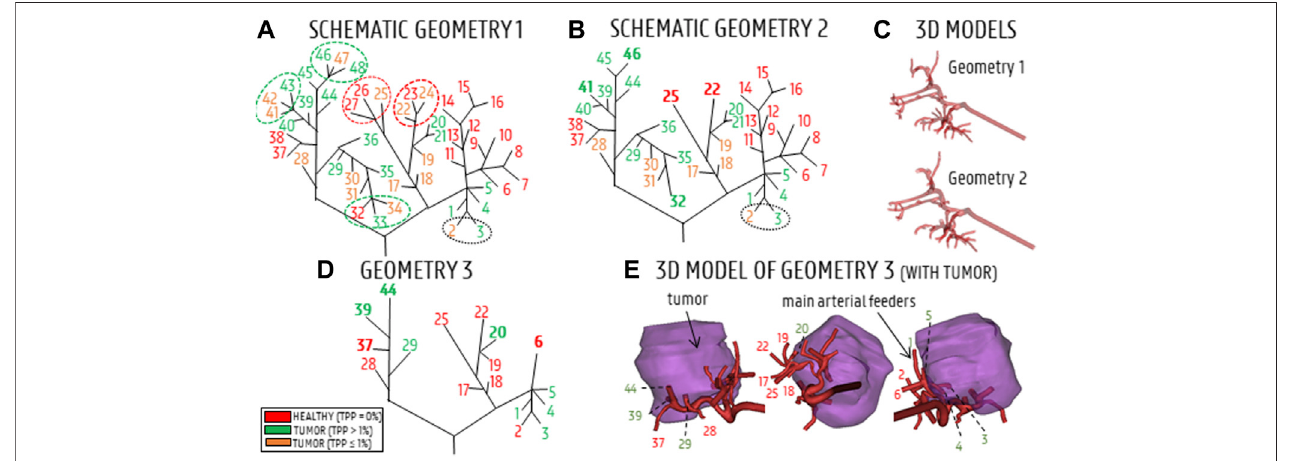
FIGURE2|(A) SchematicofGeometry 1.Redbranchesindicatehealthybranches (TPP=0%), orangebranchesindicatebranchesthatperfuseasmallfraction of thetumor(TPP ≤ 1%),greenbranchesindicatebranchesthatperfuseasigni fi cantportionoftumortissue(TPP > 1%).EllipsesindicatewhichbranchesofGeometry1were pruned. (B) Schematic of Geometry 2; bold indices indicate where arteries were pruned. (C) 3D reconstructions of Geometries 1 and 2. (D) Schematic of Geometry 3, with the main arterial feeders denoted in green and the healthy-perfusing branches denoted in red. (E) 3D model of Geometry 3 (3 views), showing the relative position of the 17 outlets with respect to the tumor